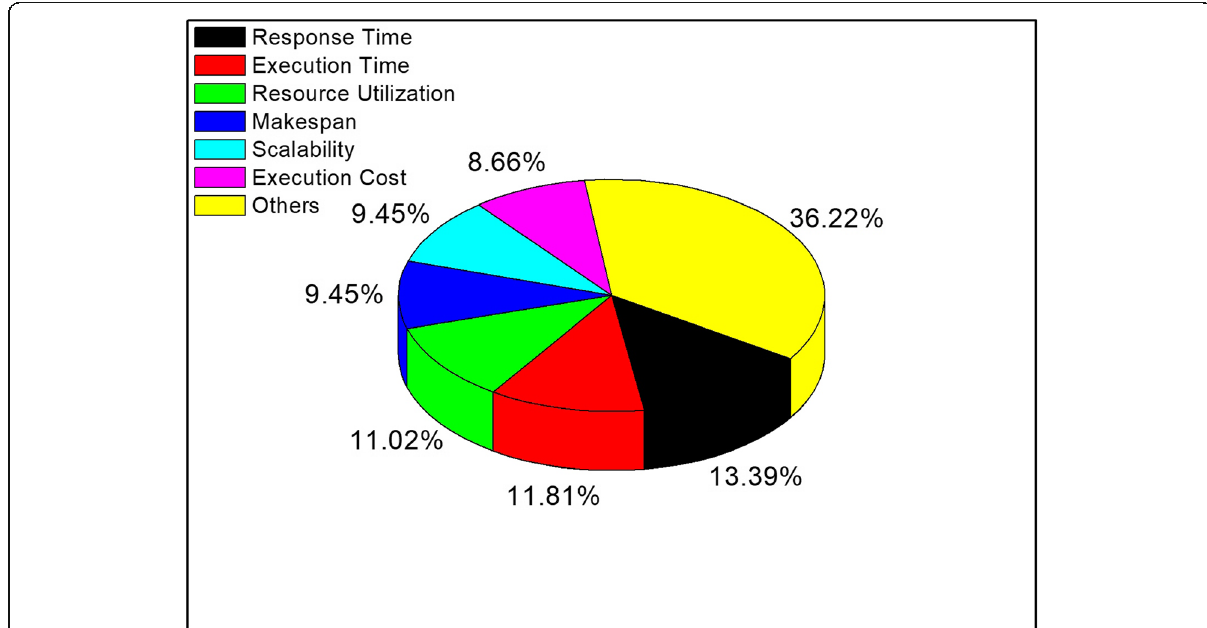
Fig. 12 Percentage of LB metrics in Existing